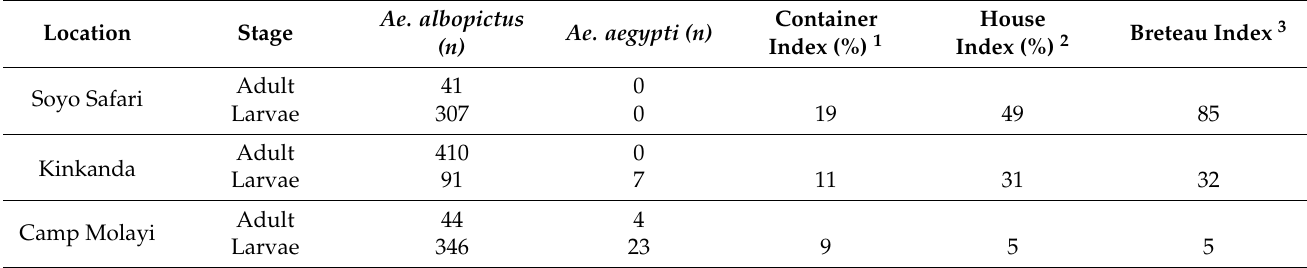
Table 2. Entomological data of the outbreak investigation in Matadi per neighborhood in which Aedes mosquitos were captured. Location